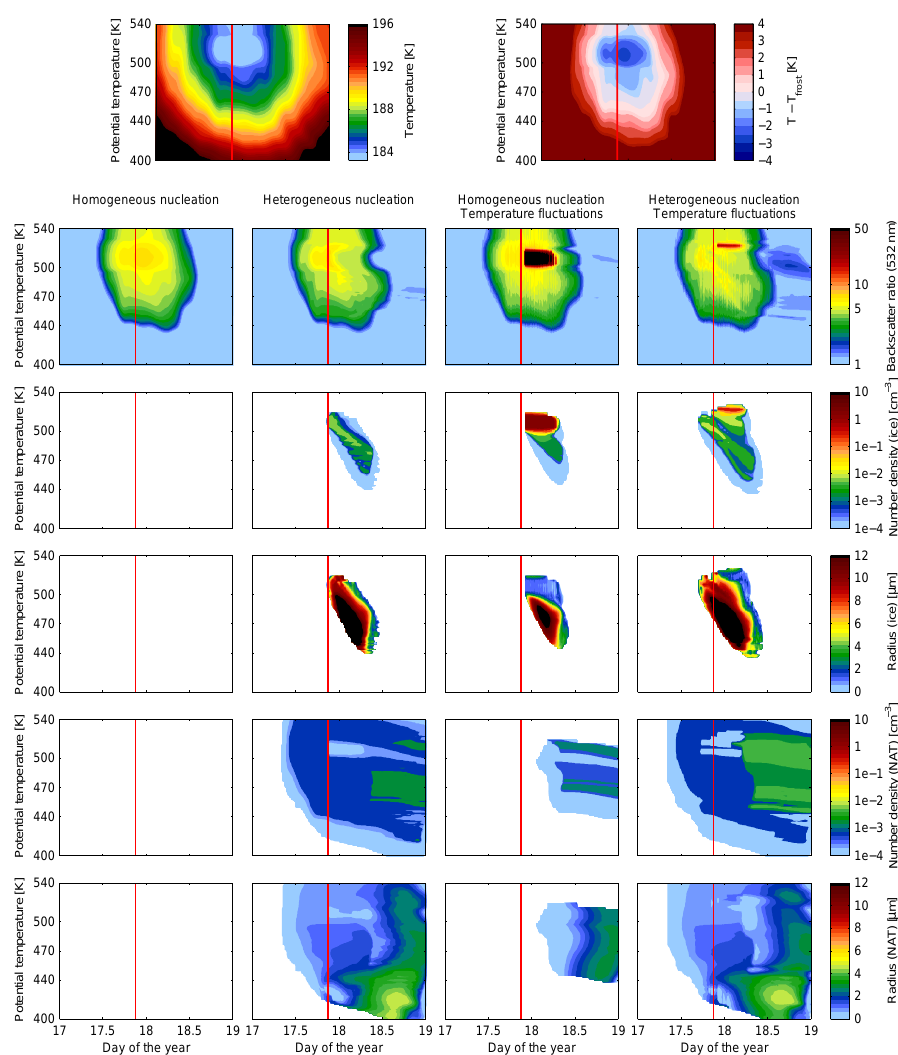
Fig. 5. Results from the microphysical column model ZOMM driven by ERA-Interim based CLaMS trajectories (17–19 January 2010). Vertical red line: S1. Top panels: ERA-Interim temperatures (temperature correction applied) shown as absolute temperature (left panel) and relative to the frost point temperature ( T frost ), which has been calculated from the climatological mean water vapor profile (right panel). Rows: backscatter ratios at 532nm, ice and NAT number densities and radii. Columns show four different scenarios: column 1 – only homogeneous nucleation of ice, no superimposed temperature fluctuations; column 2 – same, but in addition allow for heterogeneous nucleation; column 3 – only homogeneous nucleation of ice, but with superimposed small-scale temperature fluctuations; column 4 – with both, heterogeneous nucleation and superimposed temperature fluctuations. Homogeneous simulations include homogeneous ice nucleation and NAT nucleation on preexisting ice particles only. Heterogeneous model runs also include heterogeneous ice and NAT nucleation on foreign nuclei.